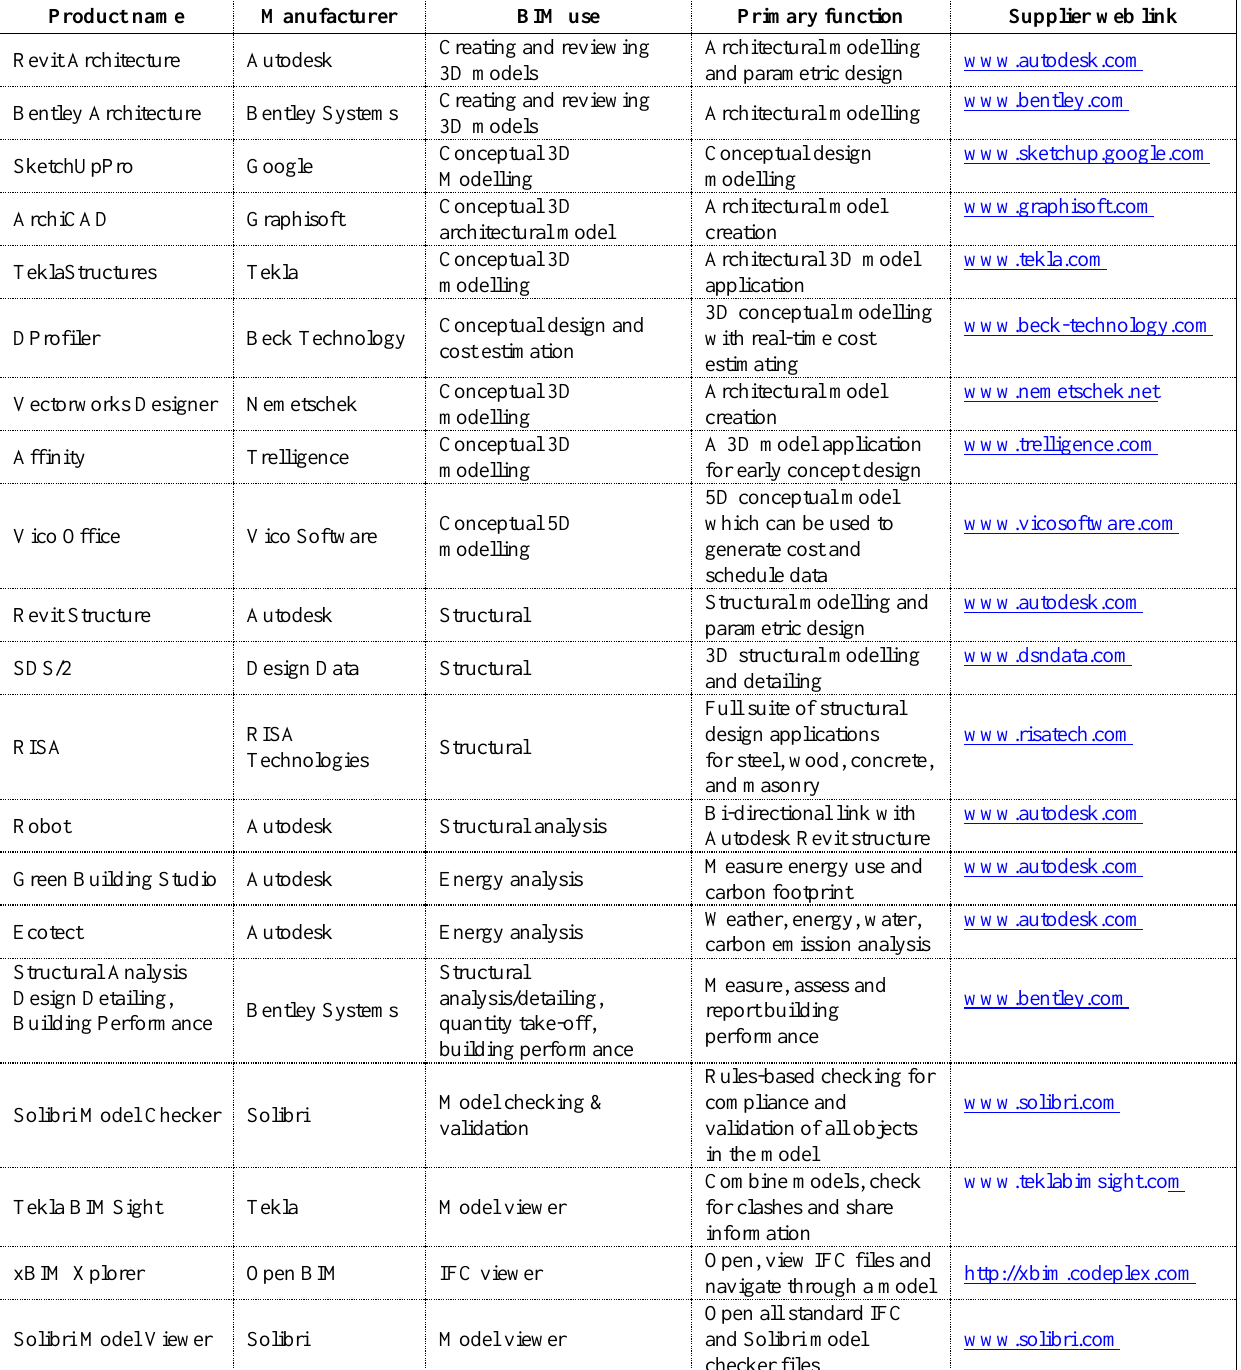
Table 1. Existing BIM tools (Logothetis et al.,